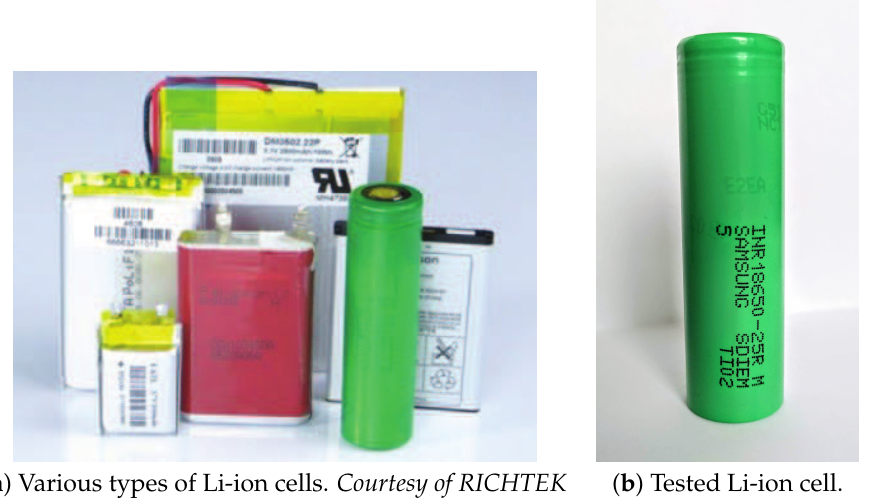
Figure 1. ( a ) comparison of various Li-ion cells [25], ( b ) cell used for cycling